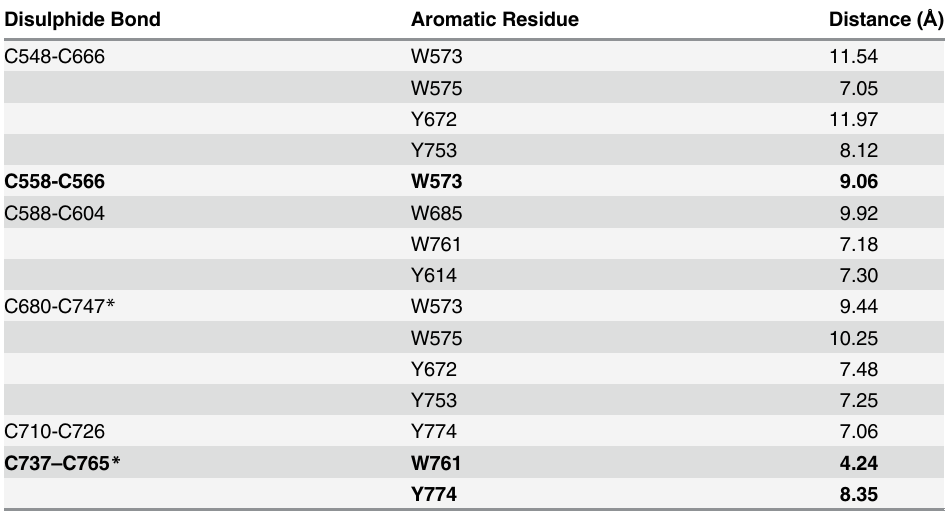
of an amino acid, which is ~ 10 Å [58]. In Table 2 are listed the Trp, Tyr-disulphide bond pairs whose inter-distance is less than 6 Å (threshold distance defined considering direct Van der Waals contact distance (cid:6) 5.2 Å [59]. We can find Trp, Tyr-disulphide bond pairs in or close to Van der Waals contact in all protein domains. In Fig. 1 (bottom panel) is displayed the catalytic domain of plasminogen, which contains 6 disulphide bonds, 6 Trp and 5 Tyr residues. In Table 3. Shortest spatial distances between disulphide bonds and aromatic residues (tryptophan and tyrosine) in the serine protease domain of human plasminogen.